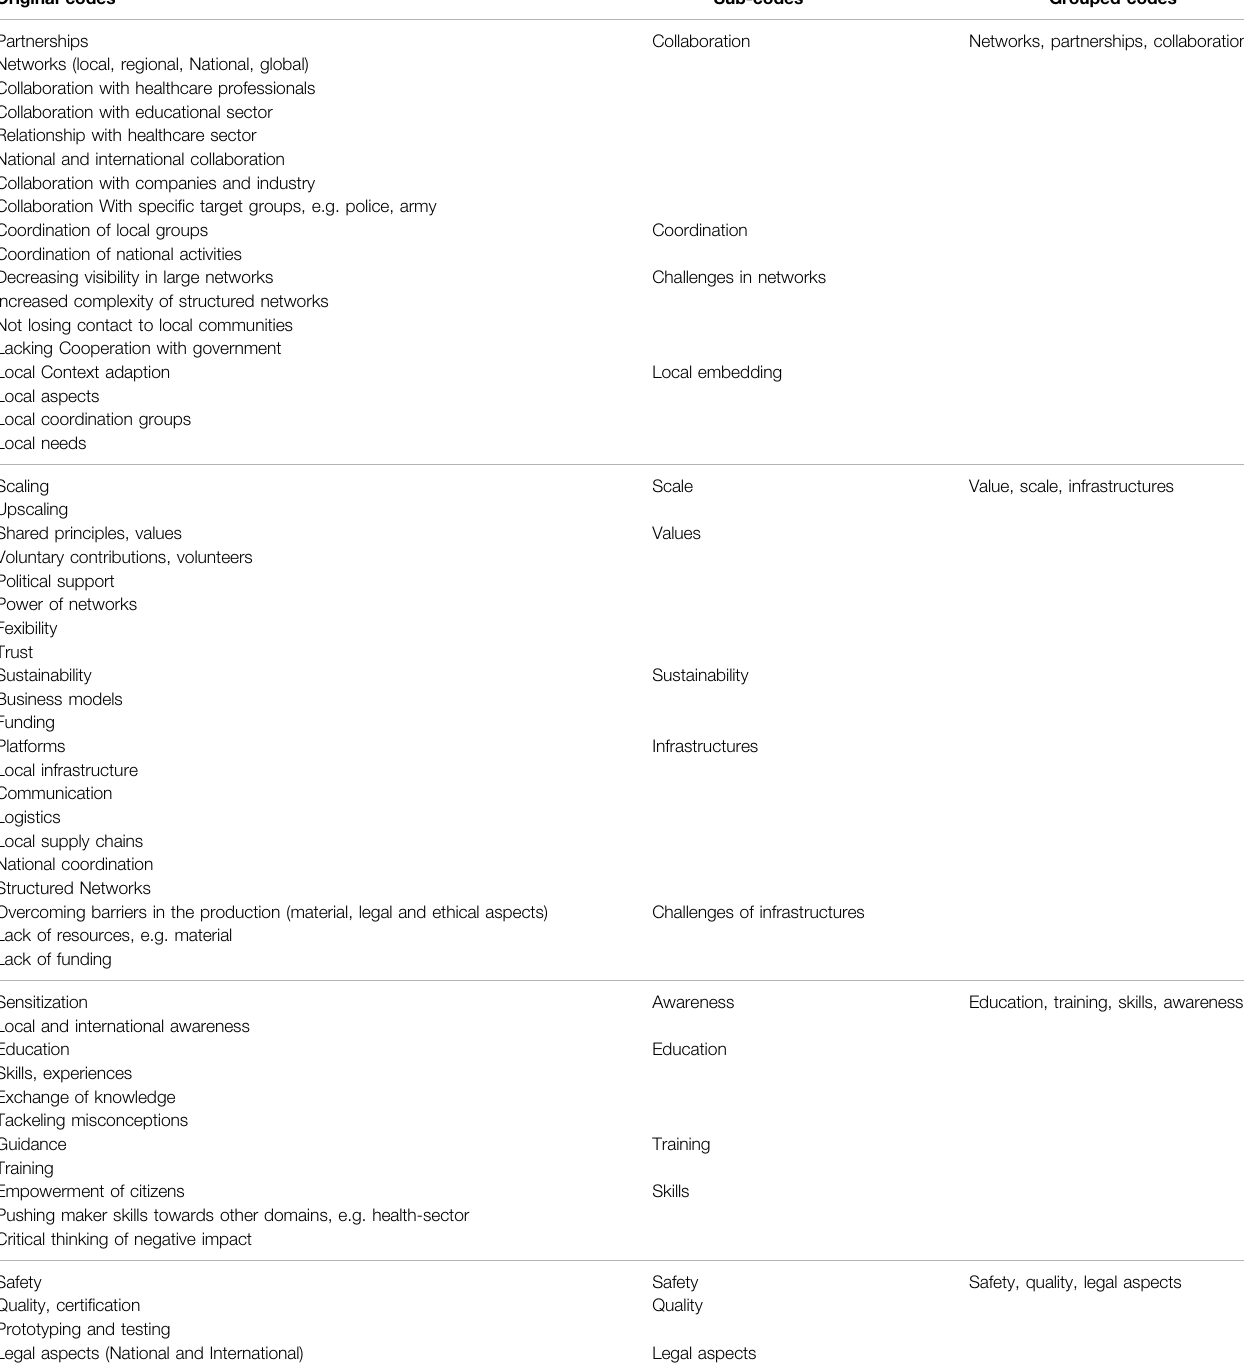
TABLE 1 | Overview of codes, sub codes, and their grouping Original